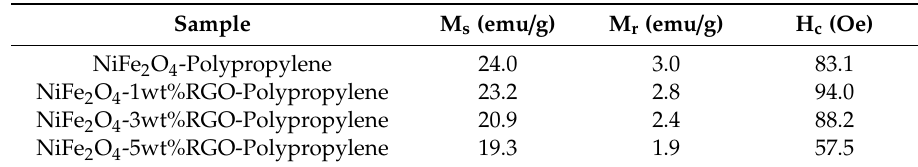
Figure 9. Magnetic hysteresis curves of polypropylene nanocomposites filled with spinel ferrite NiFe 2 O 4 nanoparticles and in-situ reduced graphene oxide (RGO). Inset is enlarged view. Table 1. Saturation magnetization (M s ), remanent magnetization (M r ), and coercivity (H c ) of prepared nanocomposite